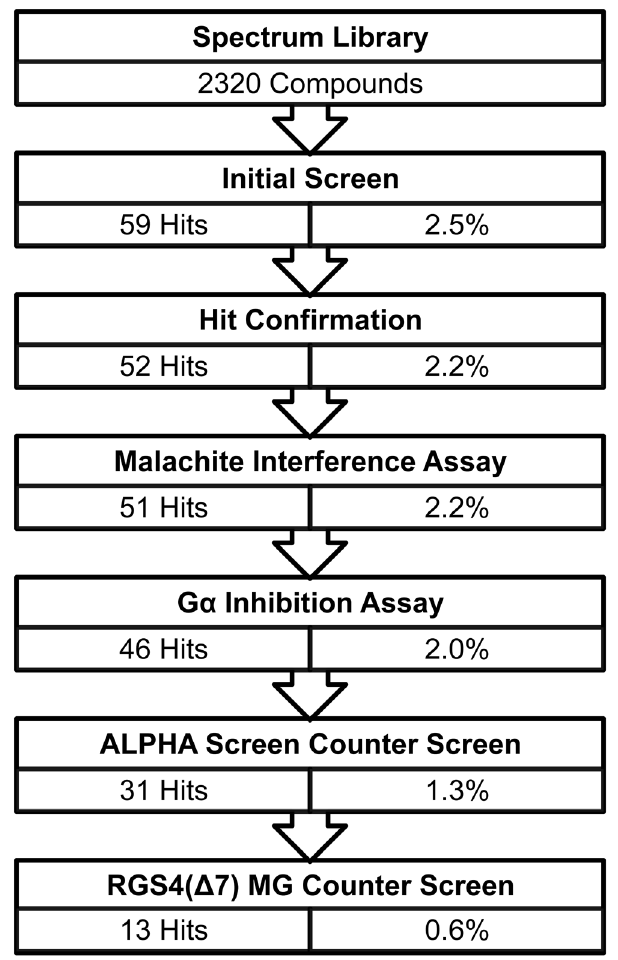
Figure 10. Pilot screen results for Spectrum Library. From the 2320 compound library, 59 compounds (2.5%) were considered hits. 52 of those compounds were confirmed in a single point assay. 6 compounds were found to inhibit either the assay or the G a i directly, leaving 46 compounds (2.0%). An additional 15 compounds were removed for failing the ALPHA Screen orthogonal assay. And finally, 18 compounds were found to not inhibit RGS4( D 7) at least 25% in the single point counter screen, leaving 13 compounds